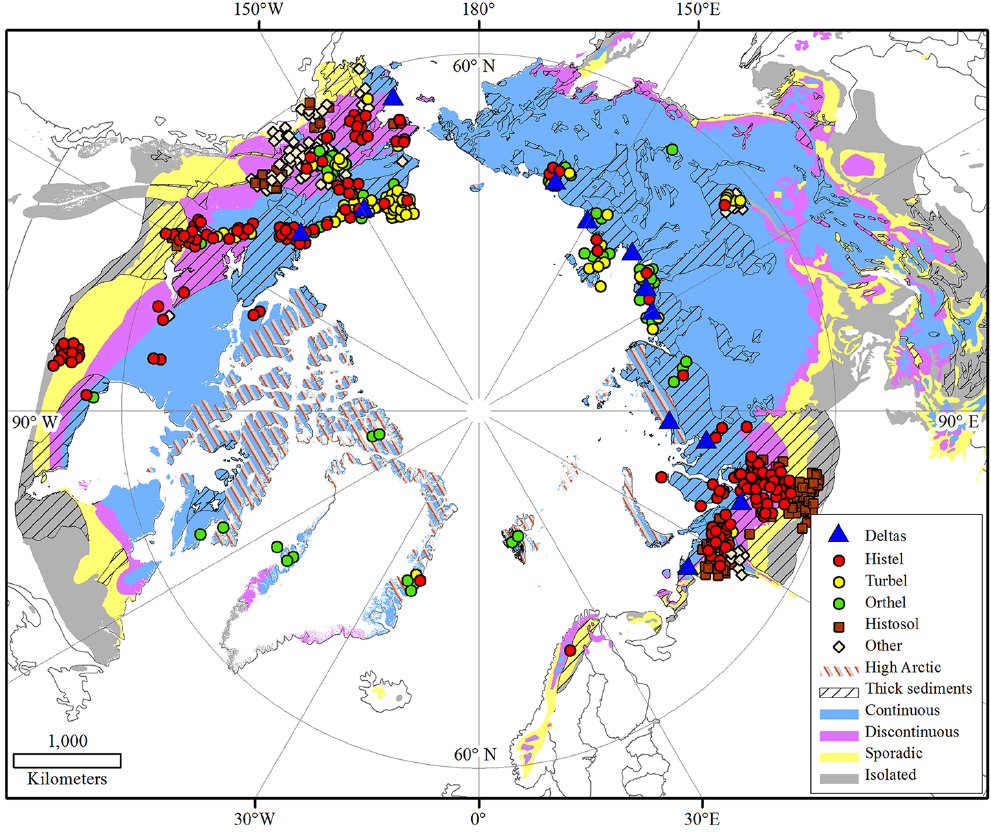
Figure 1. Geographical distribution of regions with thick sedimentary overburden and permafrost zonation in the northern circumpolar permafrost region (Brown et al., 2002). Map shows locations of the included Arctic river deltas as well as pedons with data in the 0–3m depth range (pedon data set 2), grouped according to NCSCDv2 upscaling classes. Exact pedon locations have been manipulated for cartographic representation; projection: Azimuthal Equidistant, datum: WGS84. Adapted from Hugelius et al.